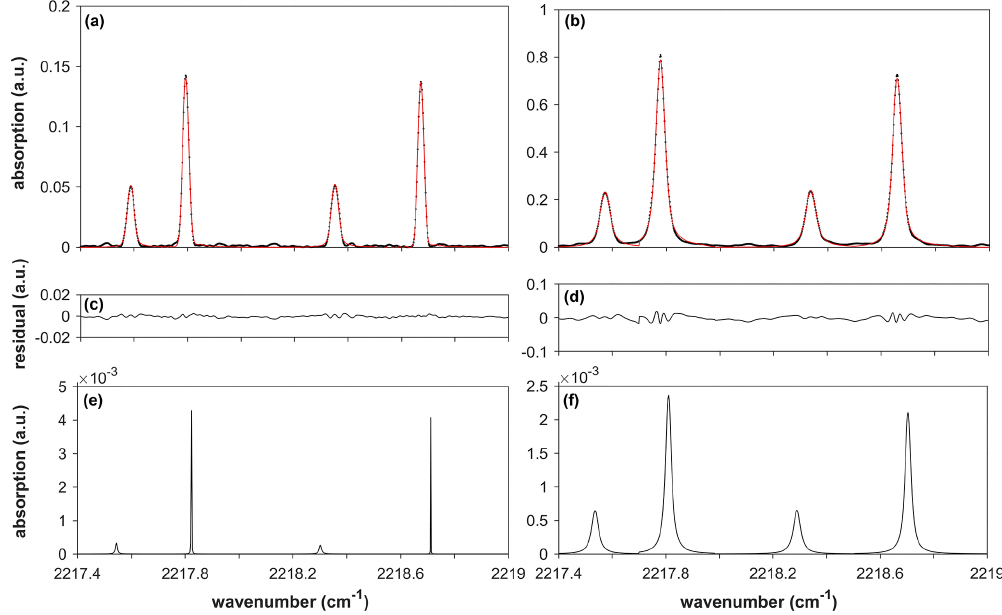
Figure 1. Instrumental line shape (ILS)-convoluted Voigt fit of the measured spectrum of the reference cell (a) . ILS-convoluted Voigt fit of the measured spectrum of the multipass cell (b) . The residuals of each fit are shown in (c) and (d) ; (e) and (f) show ILS-deconvoluted spectra of the reference and multipass cells. The areas under the ILS-deconvoluted spectra are compared, and the optical path length (OPL) of the multipass cell is determined using Eq. (4). The areas for the reference and multipass cells are 2.9 × 10 − 5 and 2.2 × 10 − 4 , respectively, resulting in an OPL of the multipass cell of 3.169 ±